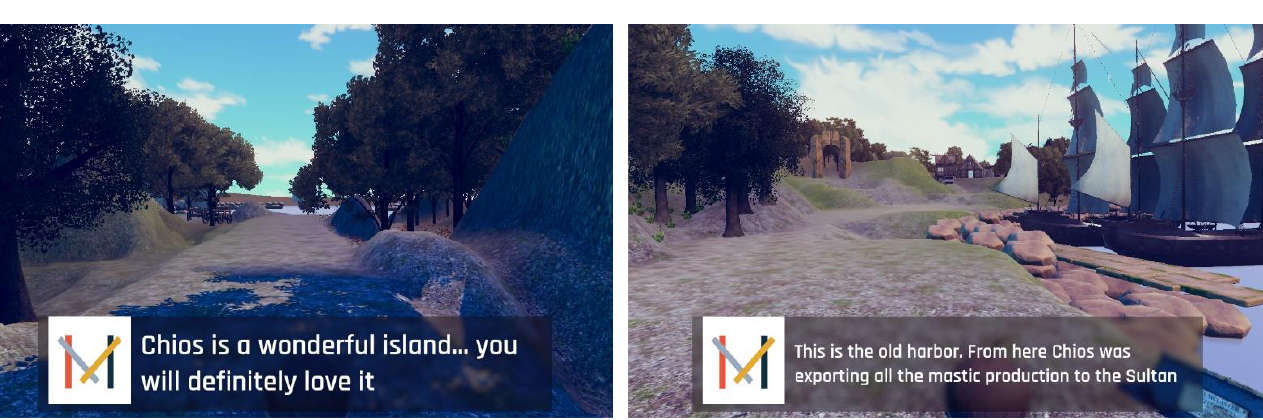
Figure 19. Chios airborne — standalone version.